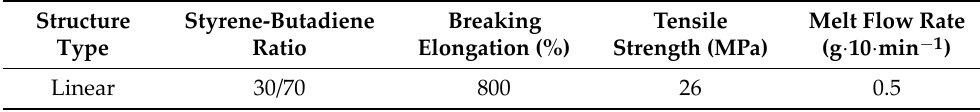
Table 2. SBS basic physical performance indexes.